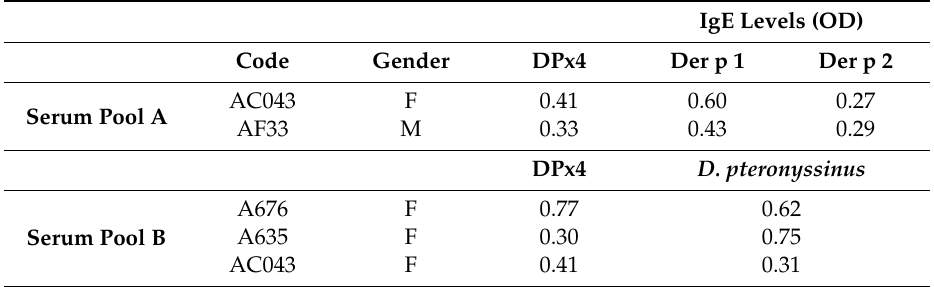
Table 2. Characteristics of sera used for preparation of serum